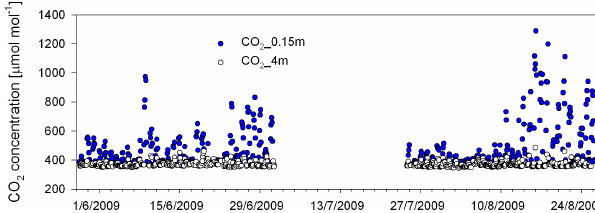
Fig. 13. CO 2 concentrations at the eddy measurement height (4m) and at 0.15m above ground level,